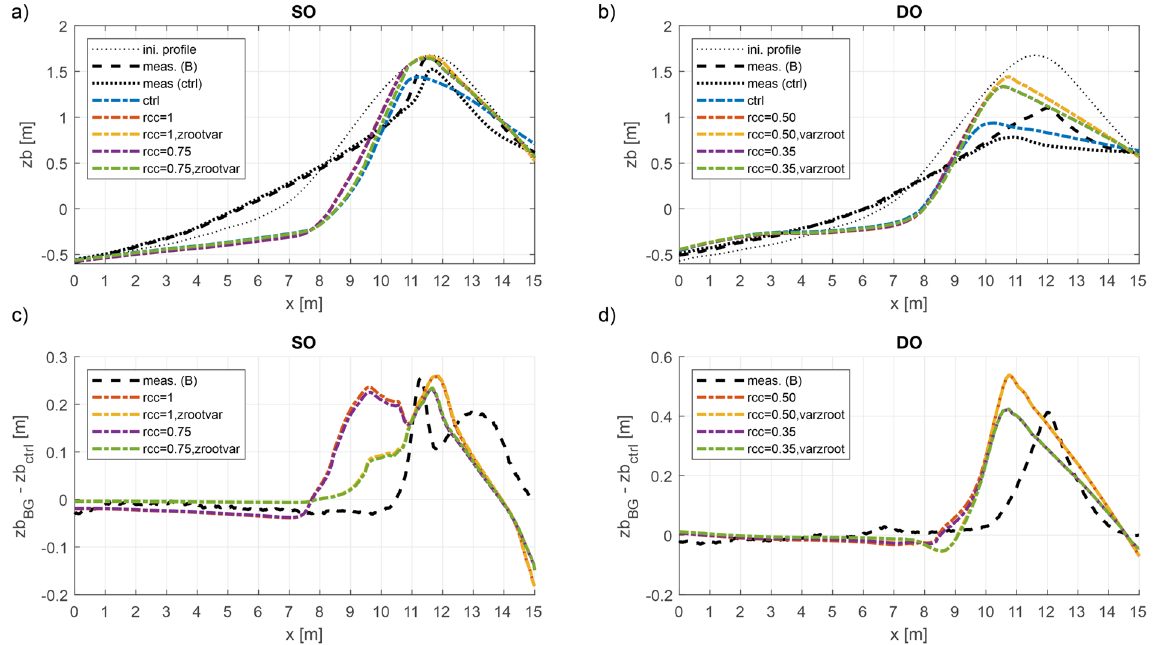
Figure 7. Modeling overwash conditions with belowground biomass: Comparison of initial (thin dotted), final measured control (thick dotted) and final measured BGB (dashed) dune profiles with simulation results (dash-dotted), including the control simulation (blue) and the application of the root model (color) for shallow overwash ( a ) and deep overwash ( b ). Profile differences (belowground to control) are shown for the measurements (dashed) and the simulations (dash-dotted) for shallow- ( c ) and deep-overwash ( d ). Note : Overlay of the lines of the simulations with equal rcc value in dune crest area.